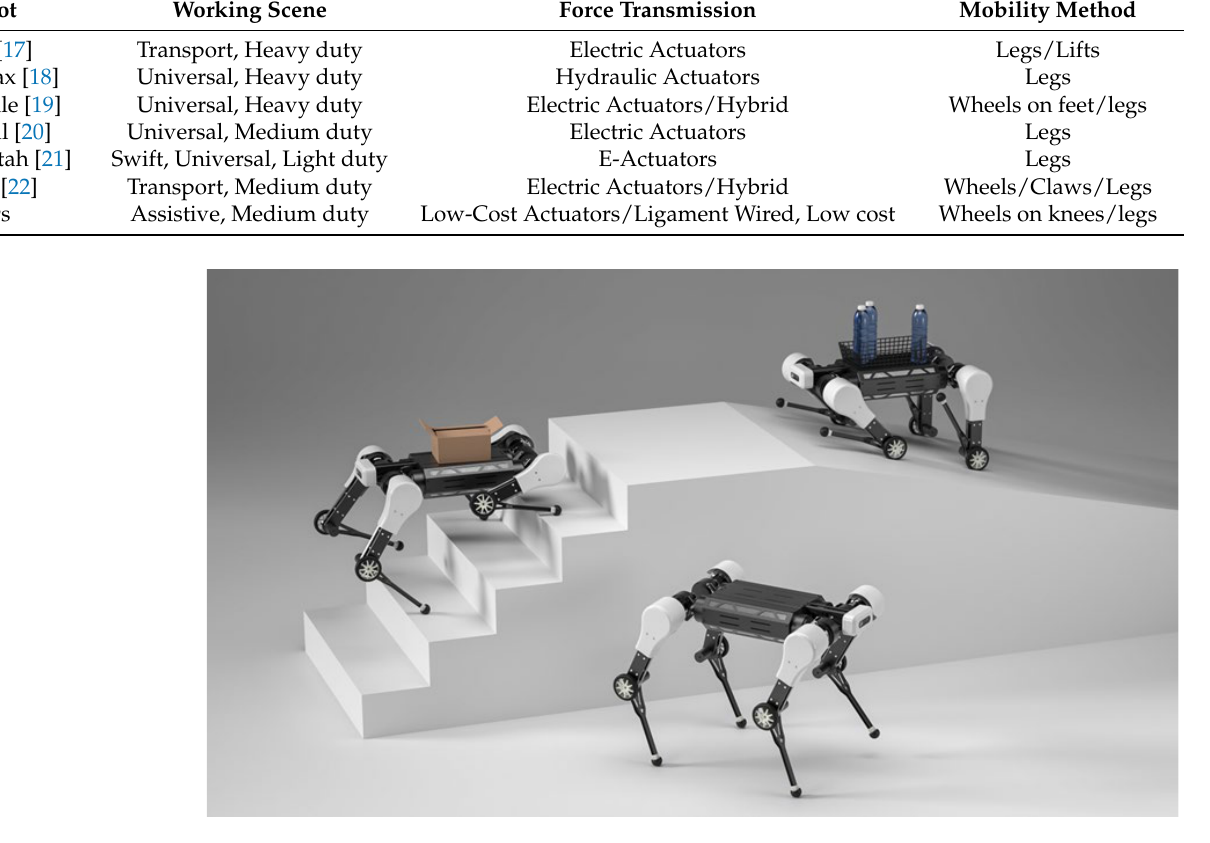
Figure 1. The design of the quadruped-assistive-robot platform. The wheel-footed robot can carry items while keeping the torso horizontal.